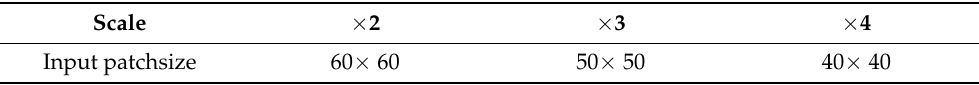
Table 3. Different scaling factors correspond to different kernel_size, padding, stride.